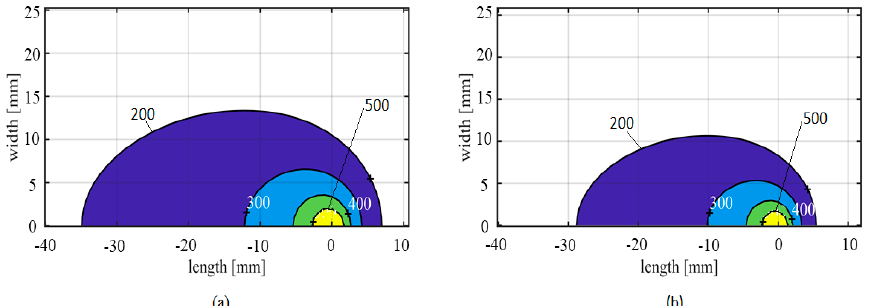
Figure 9. Calculated isothermal contour plots (degree Celsius) at pseudo-steady state for the same two butt welds referred to in Table 3; ( a ) Welding speed of 6 mm/s; ( b ) Welding speed of 8 mm/s. It is also interesting to observe that the calculated value for the net power input is seen to increase with increasing welding speeds (see Table 3). This predicted behaviour is also physically reasonable in view of how the HYB process control system actually works.